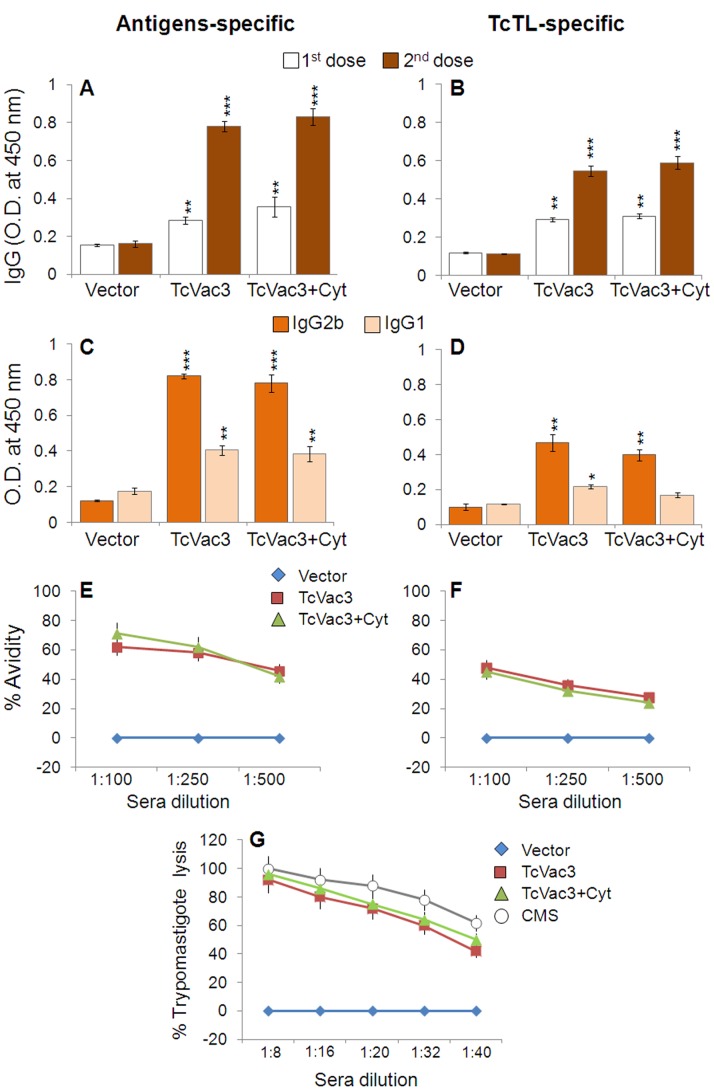
DNA-prime/MVA-boost delivery of T. cruzi candidate antigens induced Th1 polarized, high-avidity, lytic antibody response in mice.C57BL/6 mice were injected with empty vector or TcVac3 (± cytokine adjuvants), as detailed in Materials and Methods, and sera samples were obtained two-weeks after each immunization. (A–D) Sera levels of IgG (A&B) and IgG2b/IgG1 subtypes (C&D) were determined by an ELISA using recombinant antigens (A&C) or T. cruzi lysate (TcTL, B&D) to capture the antibodies. (E&F) Shown is antigen-specific (E) and parasite-specific (F) percent avidity of sera antibodies induced in vaccinated mice. (G) Tryapanolyitc activity of sera antibodies induced in vaccinated mice. The data presented in C–G was derived from sera samples obtained 2-weeks after second immunization. CMS: Chronically-infected mouse serum. In all figures, data are presented as mean ± SD, and representative of three independent experiments (n≥8, *p<0.05, **p<0.01, ***p<0.001, vaccinated-versus-controls or vaccinated/infected-versus-infected controls).